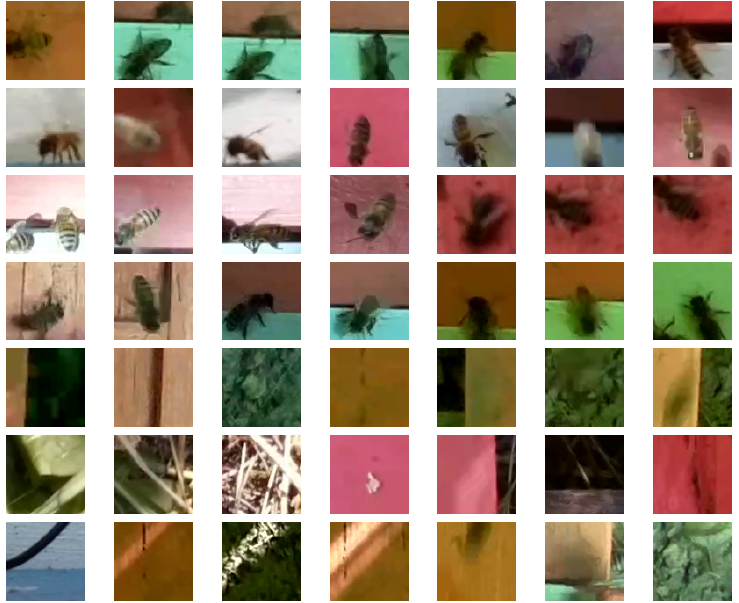
Figure 7. Sample of 2-super images from BEE2 (BEE2_2S) we used in [9]; first four rows include images classified as BEE; last three rows consist of images classified as